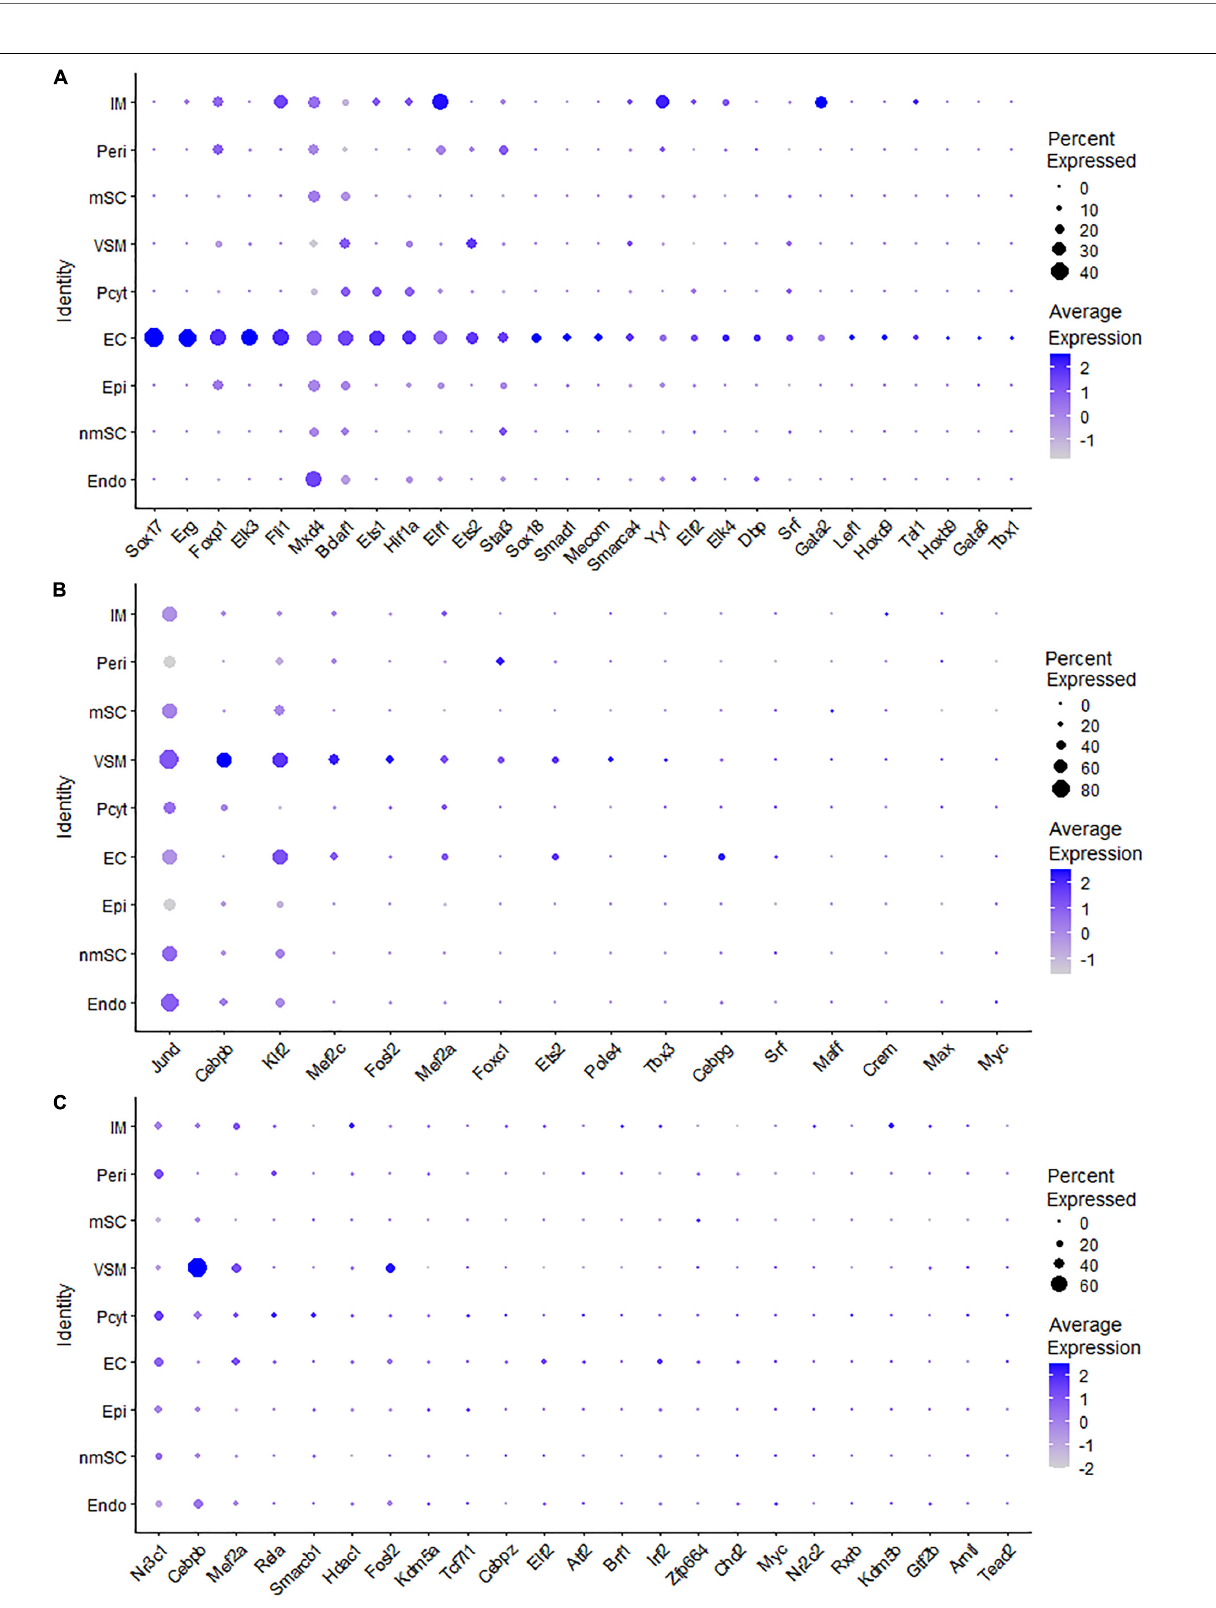
Frontiers in Cellular Neuroscience |